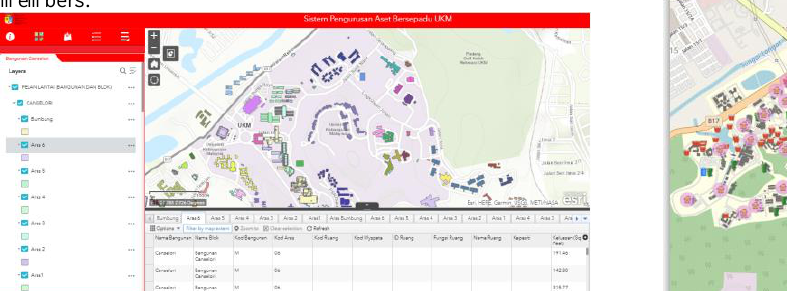
Figure 11. GIS online system for assets management.